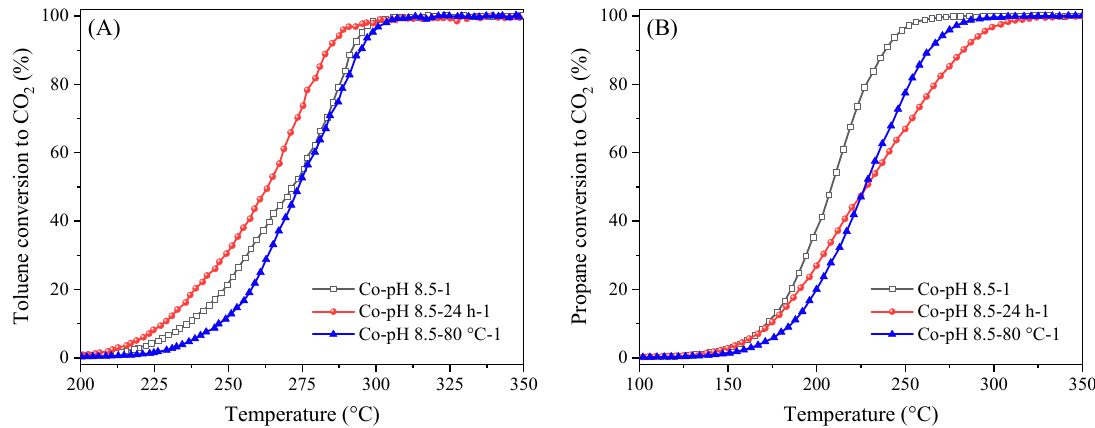
Figure 11. ( A ) Toluene and ( B ) propane oxidation over cobalt oxides prepared at different conditions. Table 5. Temperature values of 10% (T 10 ), 50% (T 50 ) and 90% (T 90 ) toluene and propane conversion of cobalt oxides prepared at different conditions.